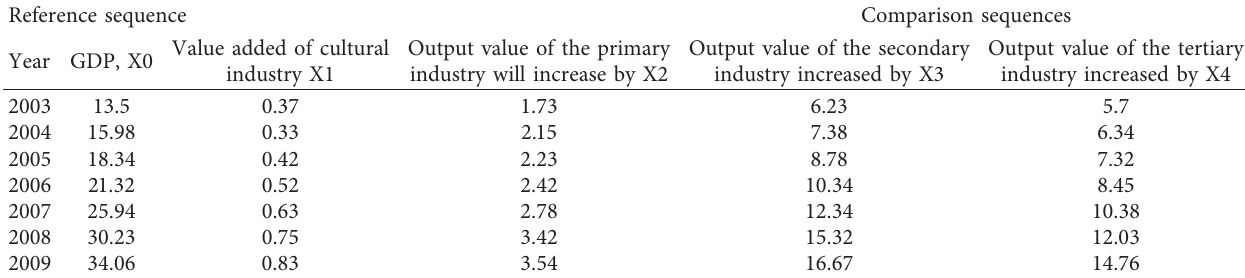
Table 2: Correlation analysis of value added of cultural industry and value added of three major industries. R11 R12 R13 R14